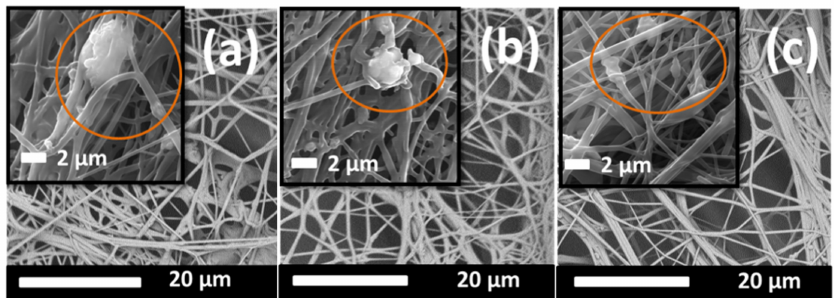
Figure 1. SEM (scanning electron microscopy) images of ( a ) PV_5_100, ( b ) PV_5_150, and ( c ) PV_5_200. Nanoparticles are indicated in the circles.